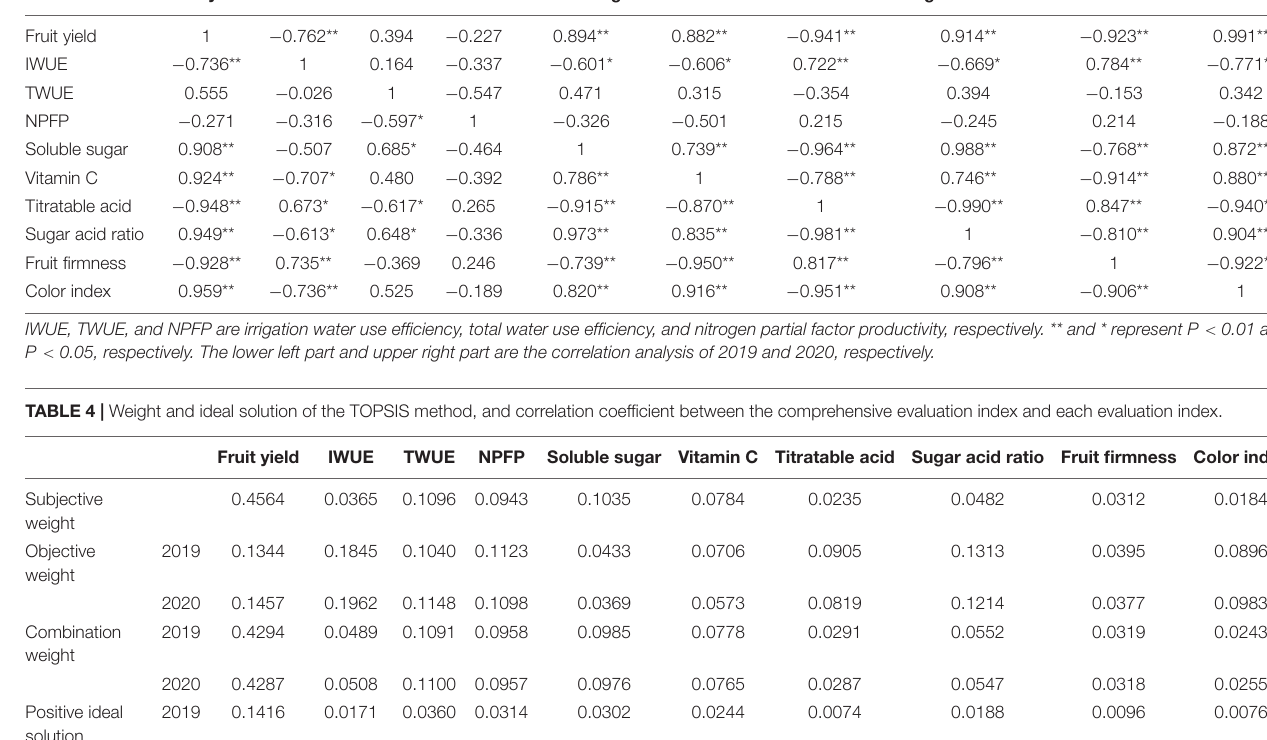
TABLE 3 | Correlation analysis of yield, water-nitrogen use efficiency, and quality of apple. Fruit yield IWUE TWUE